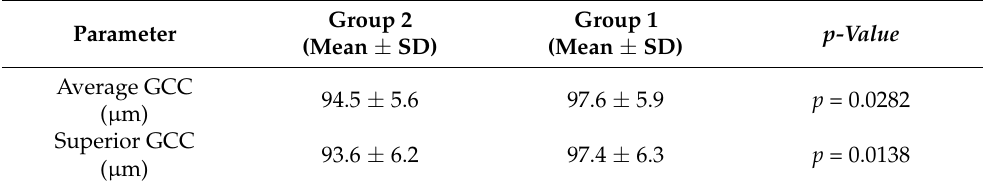
Table 6. A comparison of OCT parameters between GO patients with moderate-to-severe GO (Group 2) and patients with mild GO (Group